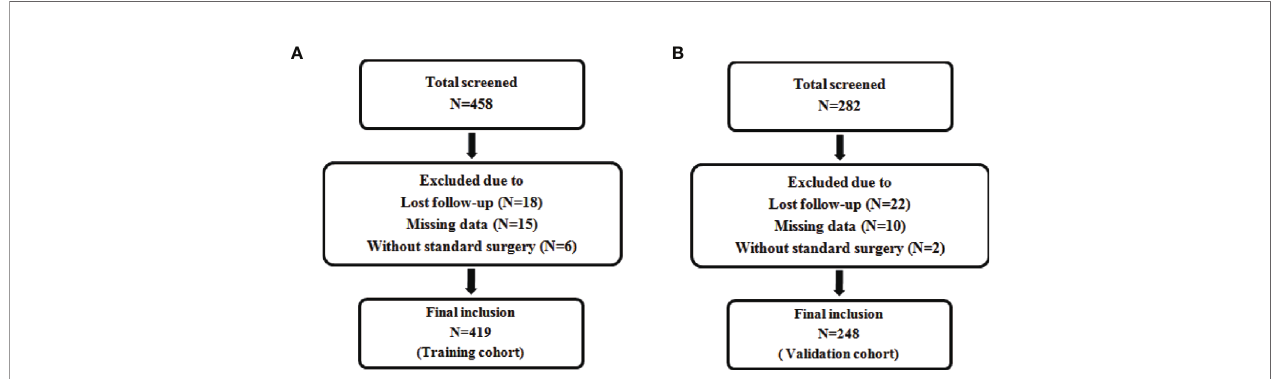
FIGURE 1 | Flow chart for patient inclusion. Description: (A) Flow chart for inclusion of patients in the training cohort. (B) Flow chart for inclusion of patients in the